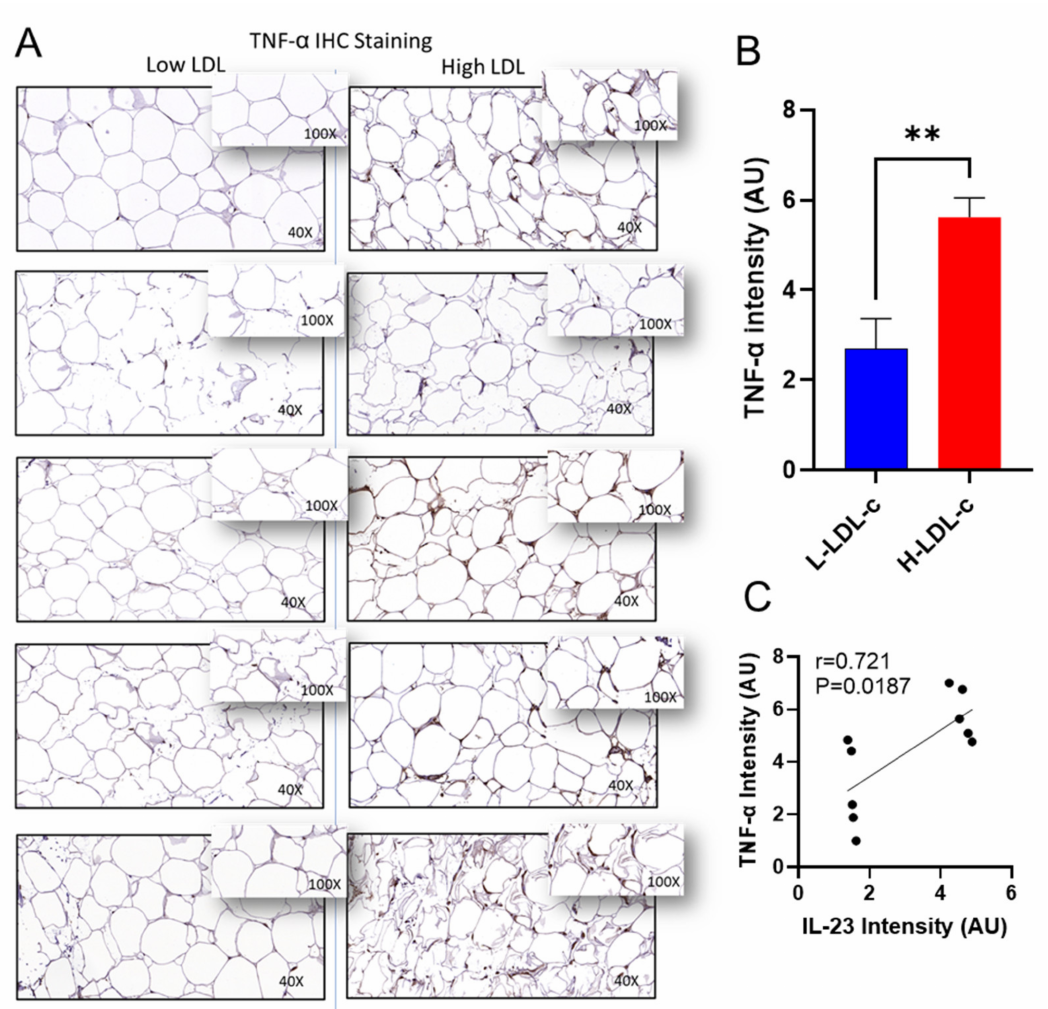
Figure 3. Increased adipose TNF- α protein expression in people with high LDL-c and positively correlated with IL-23 protein. TNF- α protein expression was determined in people with low LDL-c (L- LDL-c) and high LDL-c (H-LDL-c), five each, using IHC. ( A ) The representative IHC images obtained from three independent measurements with similar results show the elevated adipose tissue TNF- α expression (40 × or insert × 100 magnification) in people with H-LDL-c ( ≥ 2.9 mmol/L) compared to those with L-LDL-c (<2.9 mmol/L). ( B ) Elevated TNF- α protein expression is presented in the H- LDL-c group compared to the L-LDL-c group ( p = 0.0042). Staining intensity shown as arbitrary units (AU) was determined based on Aperio-positive pixel counts (Aperio software algorithm, version 9.0). ( C ) IL-23 protein correlated with TNF- α protein in adipose tissue. p -values < 0.05 were considered as statistically significant. ** Highly